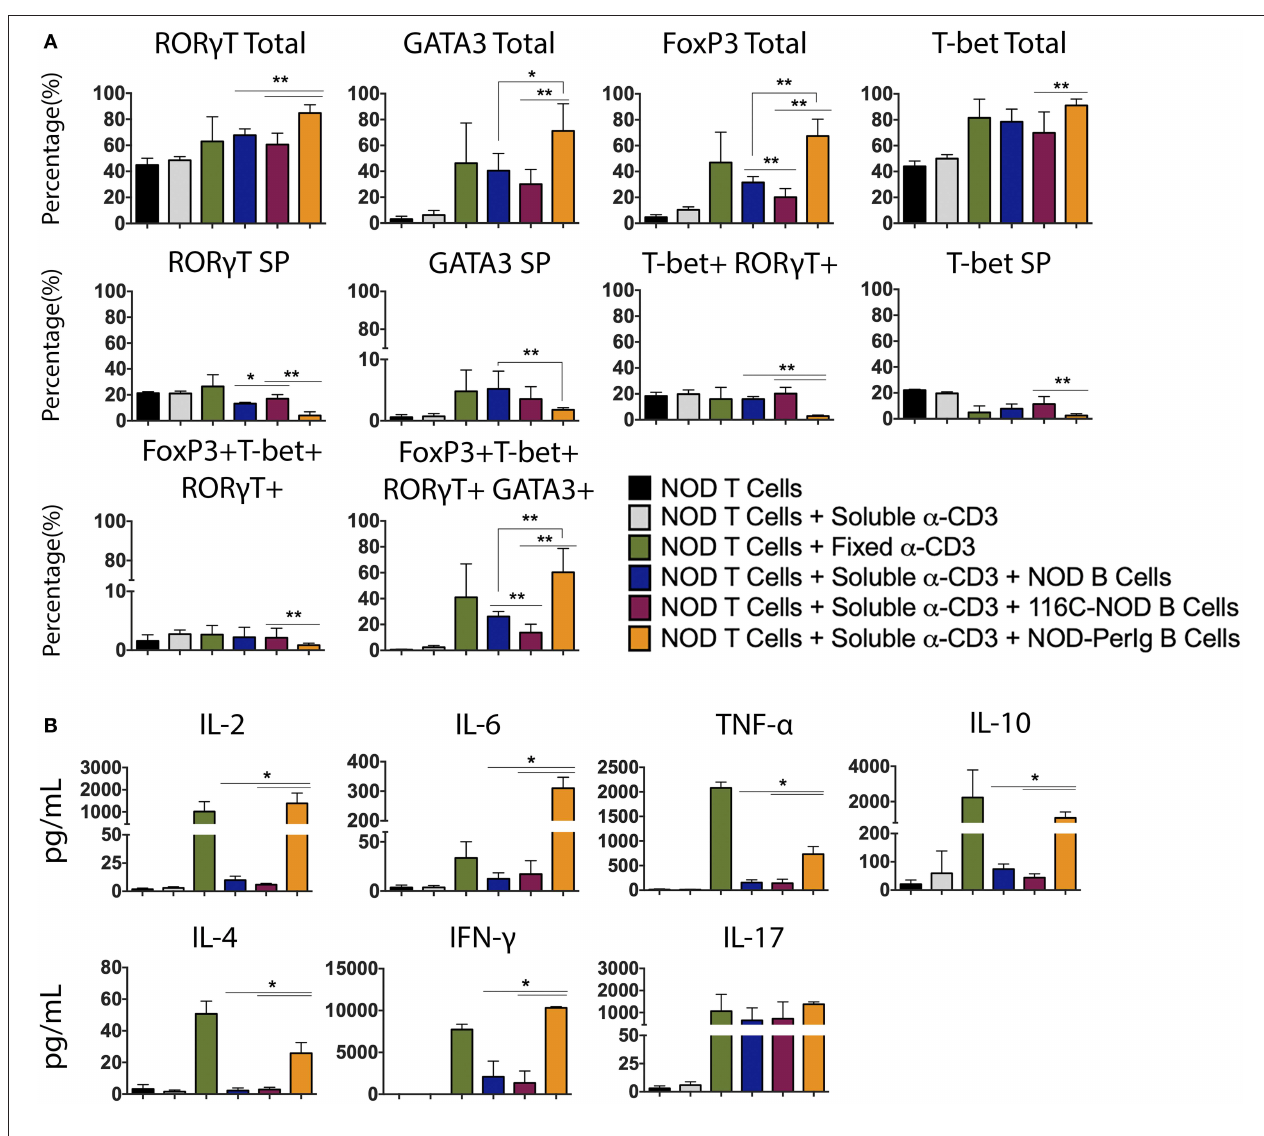
FIGURE 5 | Phenotype analysis of NOD T-lymphocytes after culture with B-lymphocytes from NOD, 116C-NOD, and NOD- PerIg mice. (A) Transcription factors expression analysis in splenic NOD T-lymphocytes cultured in the presence of soluble anti-CD3, or plate-coated anti-CD3, or either purified NOD, 116C-NOD, or NOD- PerIg B-lymphocytes plus anti-CD3, or without stimulus for 72h ( n = 6, with two replicates for each experimental condition). “Total” and “SP” stand for the percentage of “whole positive” and “single positive” cells for the aforementioned marker, respectively. (B) Cytokine concentration analysis in culture supernatants of NOD T-lymphocytes cultured in the same condition as described above. Bars show the SD of the percentage values or cytokine concentrations ( n = 4, with two replicates for each experimental condition). Mann-Whitney U, statistically significant differences: * P < 0.05 or ** P <